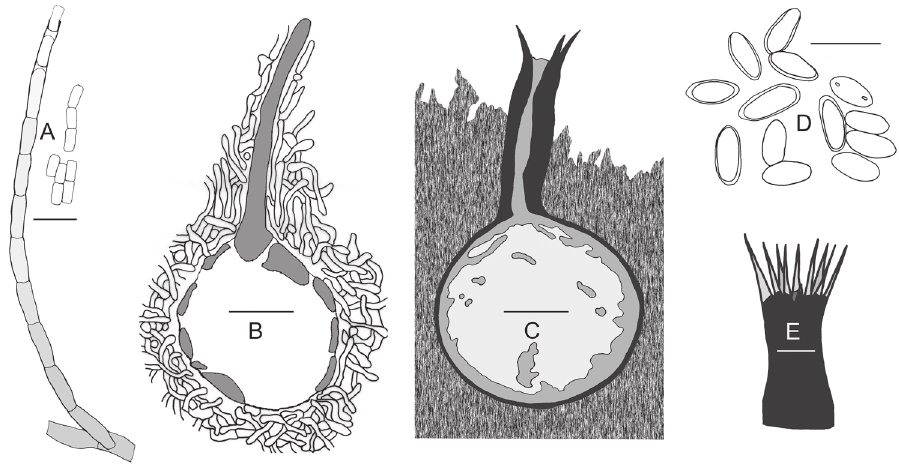
Figure 3. Line drawings of the oak wilt fungus. These illustrations are based on previously published line drawings and observations of the herbarium specimens (BPI 595712, FP 97476) in the present study. A Conidiophore and conidia in 10 % KOH (BPI 595712) B Ascomatal primordium re-drawn from Wilson (1956) C Median, histological section through ascoma embedded in the mycelial mat, re-drawn from Bretz (1952) D Ascospores in 10 % KOH (FP 97476) E Ostiolar hyphae (FP 97476). Scale bars: A, D = 10 µm, E = 50 µm, B, C = 100